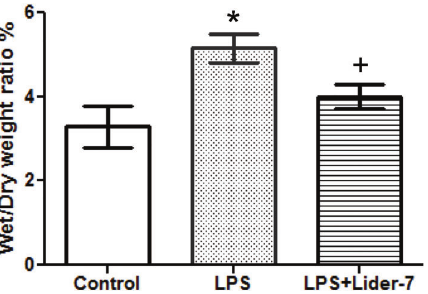
Figure 2. Comparison of the wet/dry ratio. The extent of pulmonary edema was assessed using the wet/dry ratio at 12 h after lipo- polysaccharide (LPS) infusion. Control group: n=5; LPS group: n=3; LPS + Lider-7 group: n=5. Data are reported as means ± SD. *P o 0.05, LPS group compared to control group; + P o 0.05, LPS + Lider-7 group compared to LPS group (ANOVA).